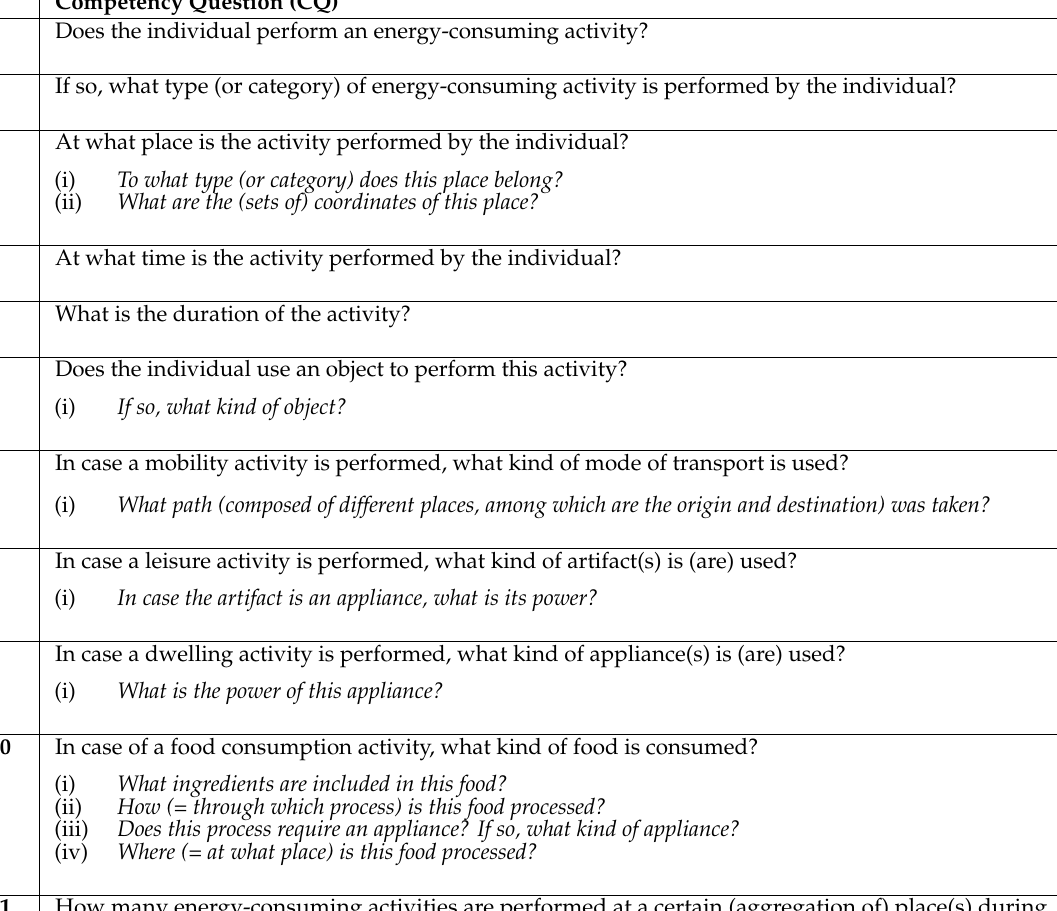
Table A1. Competency Questions that form the set of functional requirements for the SSMO